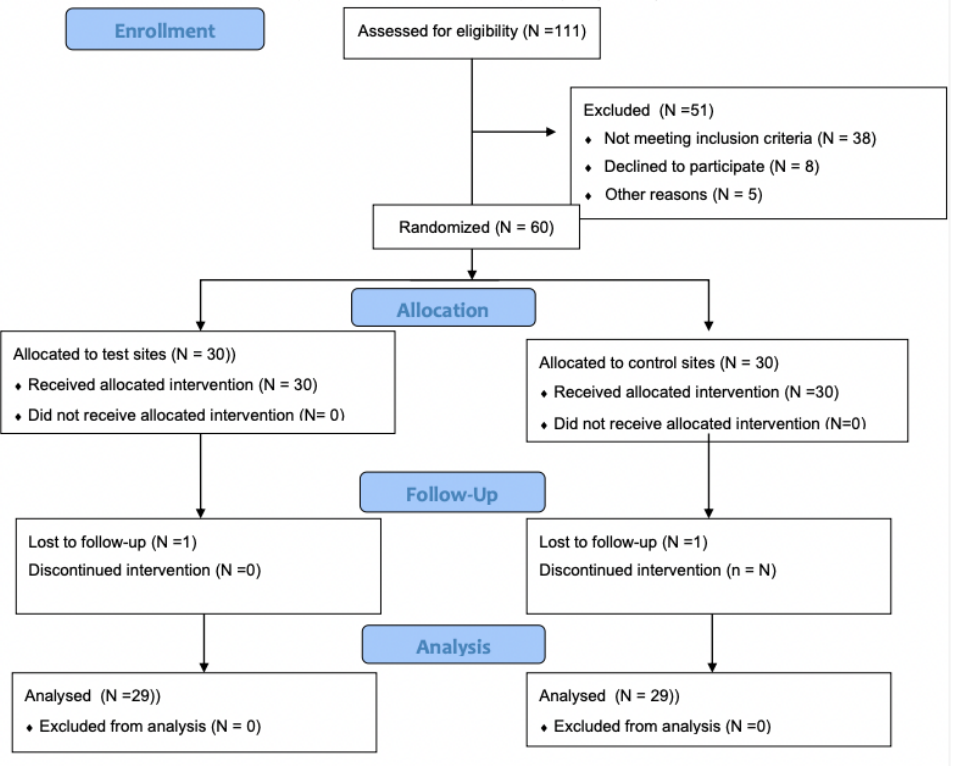
Figure 1. Consort diagram showing the study outline.